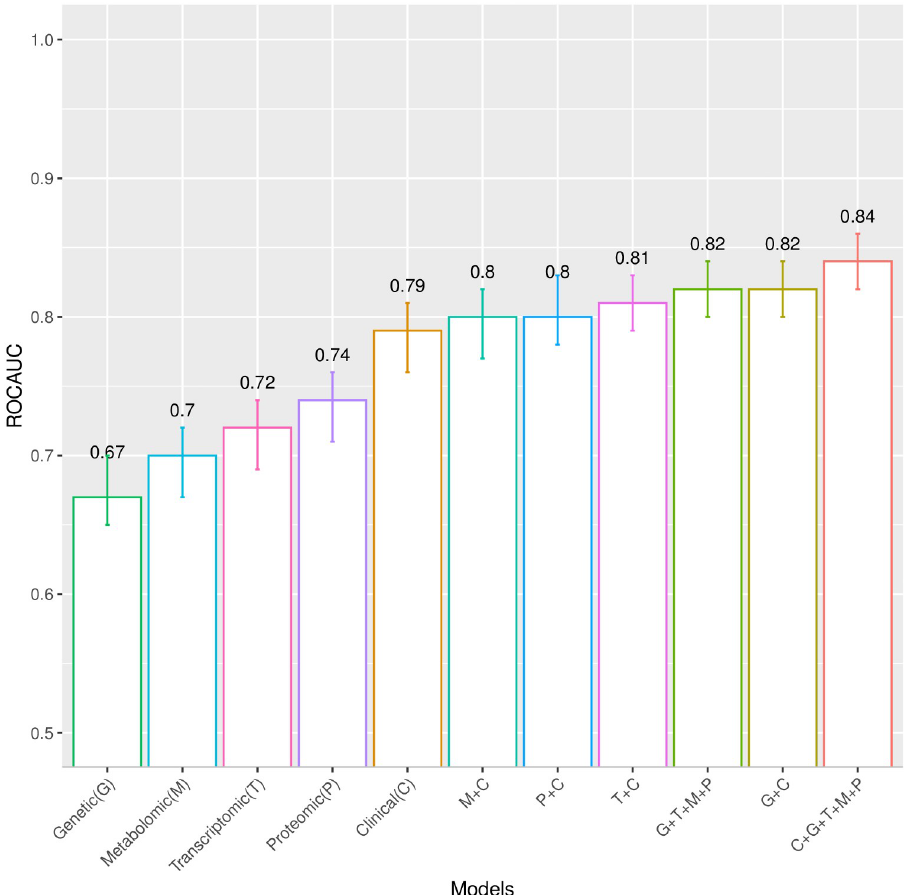
Fig 5. Receiver operating characteristic area under the curve (ROCAUC) with 95% confidence interval for the clinical model and the omics separately or in combination with the clinical model in the IMI DIRECT combined cohort. Clinical (C), model 4, with the 22 selected clinical variables. Genetic (G), model 5, with 23 SNPs. C+G, model 6, with clinical plus genetic variables. Transcriptomic (T), model 7, with 93 protein-coding genes. T+C, model 8, with transcriptomic plus clinical variables. Proteomic (P), model 9, with 22 proteins from exploratory proteomics. P+C, model 10, with proteomic plus clinical variables. Metabolomic (M), model 11, with 25 metabolites from targeted metabolomics. M+C, model 12, with metabolomic plus clinical variables. G+T+M+P, model 13, with all omics together. C+G+T+M+P, model 14, with all the omics combined with the clinical model.